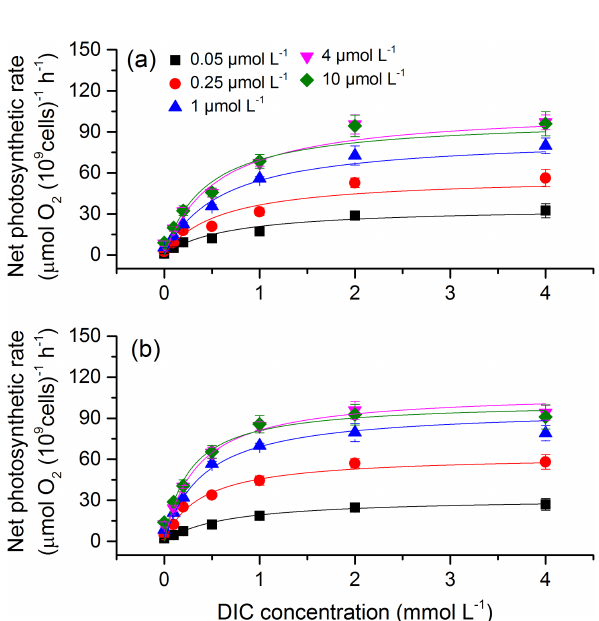
Figure 4. Net photosynthetic rate as a function of DIC for S. costa- tum grown at various phosphate concentrations after 12.6 (a) and 2.8µmol CO 2 (b) treatments. The error bars indicate the standard deviations ( n =